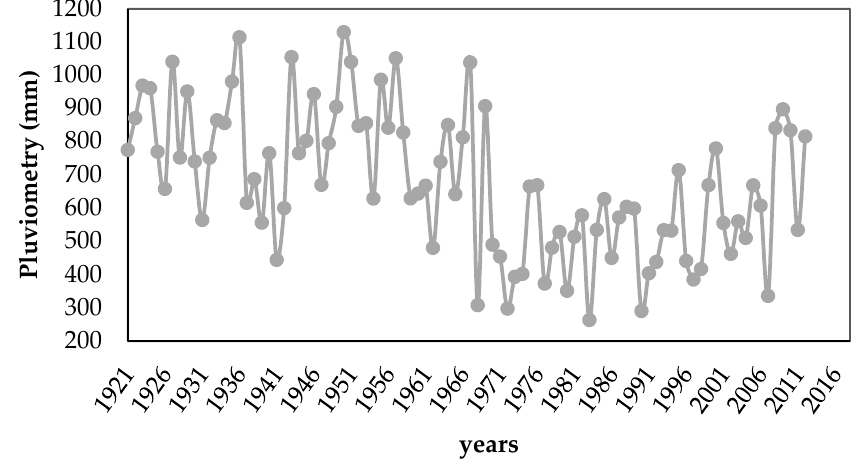
Figure A1. Rainfall data from the Fatick region (Senegal) over the period 1921–2016. Table A1. Two-way ANOVA analysis of plant species, inoculation, and their interactions with height, collar diameter, survival rate, specific contribution presence, and dry biomass .